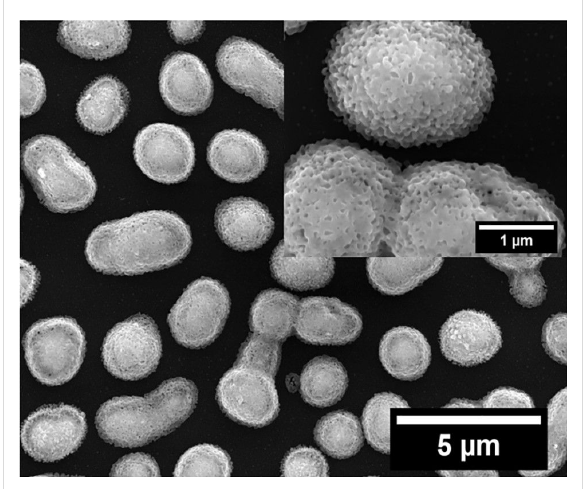
Figure 7: SEM image (10000× magnification) of a 200 nm sputtered silver film heated at 400 °C for 15 min followed by plasma treatment with oxygen plasma (g12-p200) for 10 min and reduction with hydro- gen plasma (g12-p200) for another 10 min. The inset shows particles at 50000×